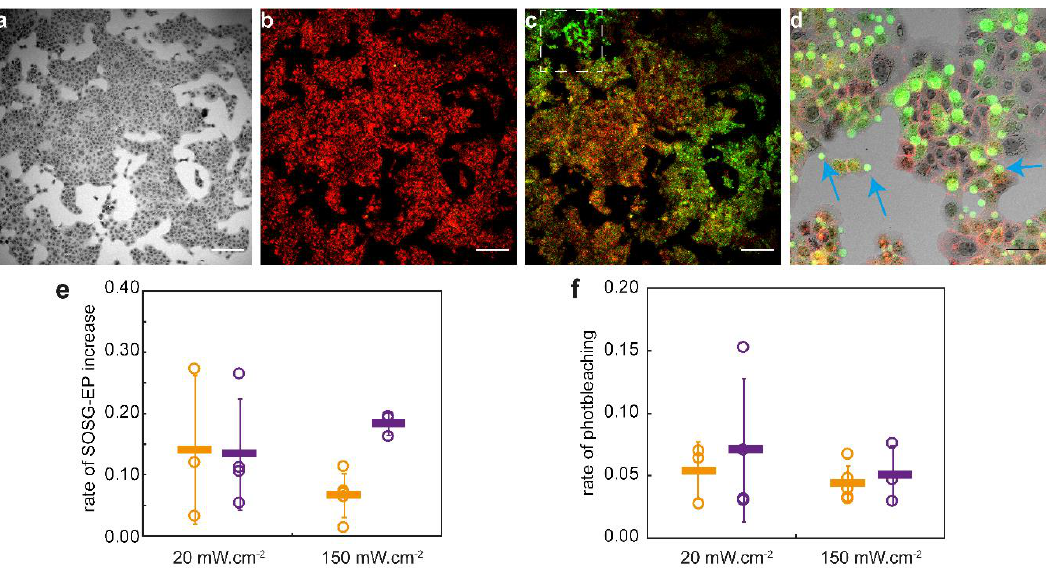
Figure 4. Example of a set of fluorescence images recorded of scc-U8 cells incubated with cetuximab-IRDye700DX for 24 h and SOSG for 2 h, illuminated with 20 mW·cm − 2 to a fluence of 7 J·cm − 2 . ( a ) transmission image of cells pre illumination. ( b ) Cetuximab-IRDye700DX fluorescence (red) and SOSG fluorescence (green) at the start of illumination. ( c ) Cetuximab-IRDye700DX fluorescence (red) and SOSG fluorescence (green) at the end of illumination. ( d ) Zoomed in image of region shown in image c. White bar is 200 µm and black bar is 50 µm. Blue arrows point to examples of blebs formed in response to the PDT treatment. ( e ) The rate of SOSG-EP fluorescence increase in counts per J·cm − 2 during illumination with either 20 or 150 mW·cm − 2 in scc-U2 (orange) and scc-U8 (violet) cells. Open circles express the weighted mean for a set of images as shown in a-c and the solid bar expresses the weighted mean over 3 – 5 sets of images. ( f ) The rate of cetuximab-IRDye700DX photobleaching in counts per J·cm − 2 during illumination with either 20 or 150 mW·cm − 2 in scc-U2 (orange) and scc-U8 (violet) cells. Open circles express the weighted mean for a set of images as shown in a-c and the solid bar expresses the weighted mean over 3 – 5 sets of images.